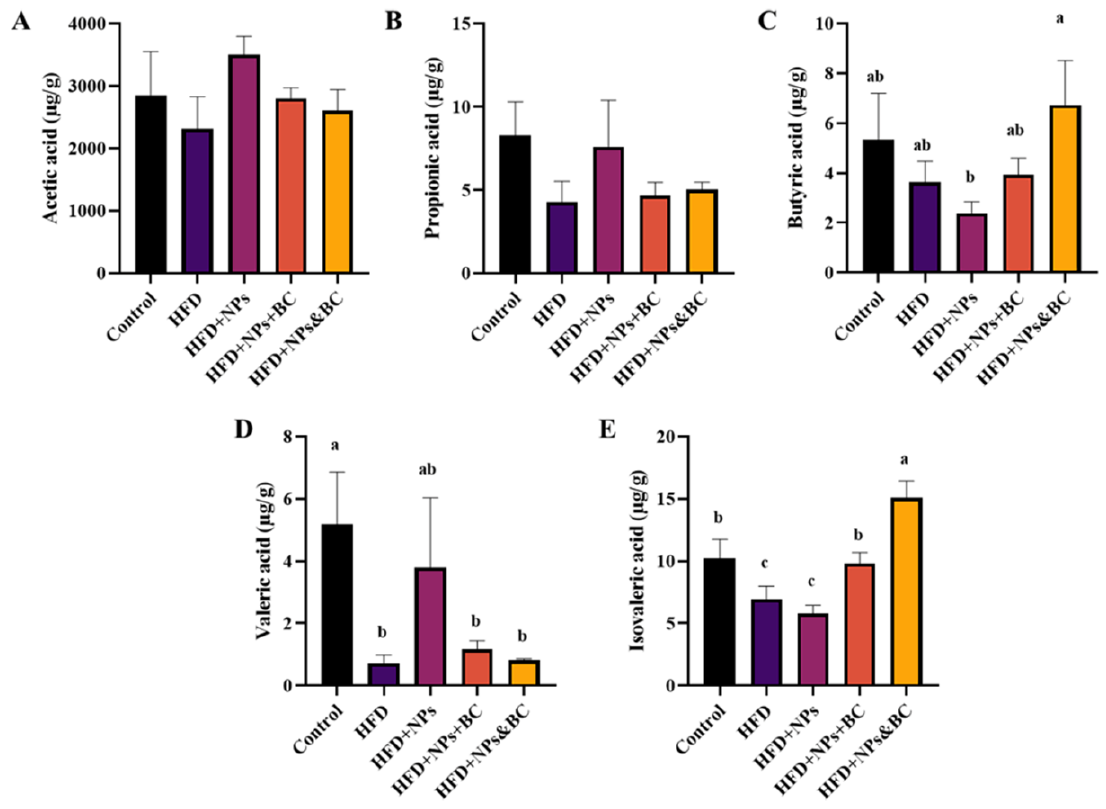
Figure 7. The levels of ( A ) acetic acid, ( B ) propionic acid, ( C ) butyric acid, ( D ) valeric acid, and ( E ) isovaleric acid. The different letters represent significant differences among groups ( p < 0.05).